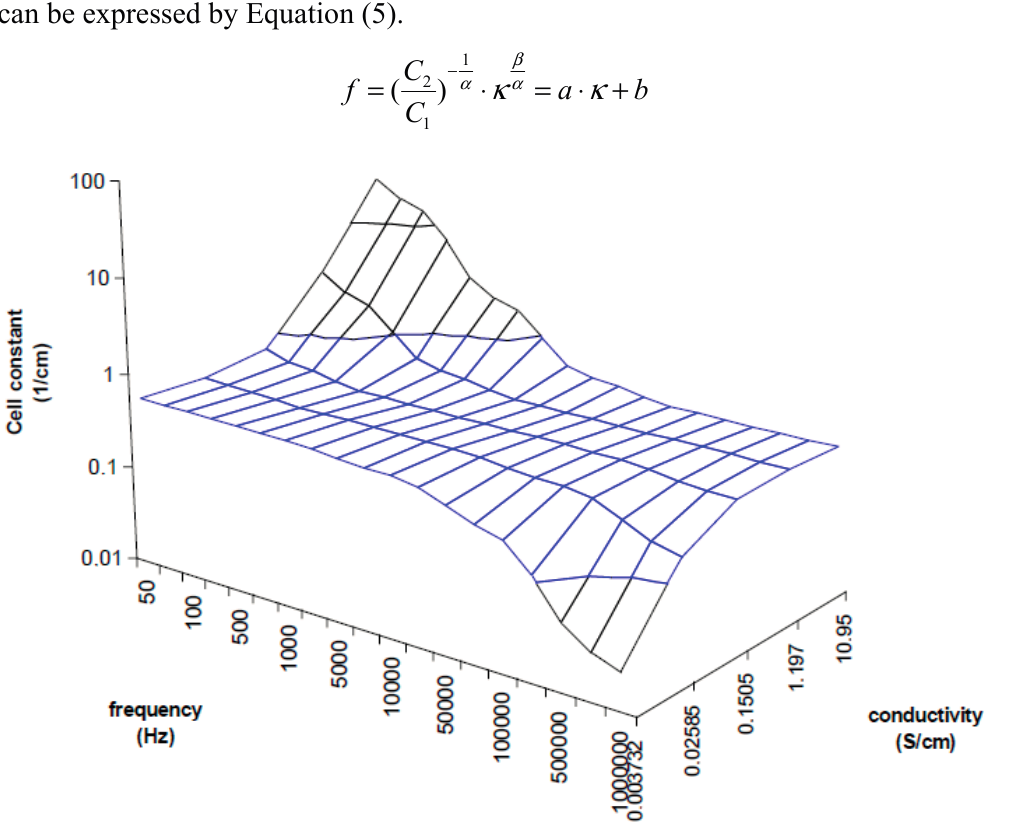
Figure 6. 3D plot demonstrating cell constant deviation according to the measuring frequency and measured conductivity. Unaccepted deviations are detected at low conductivity measured at high frequencies and high conductivity measured at low